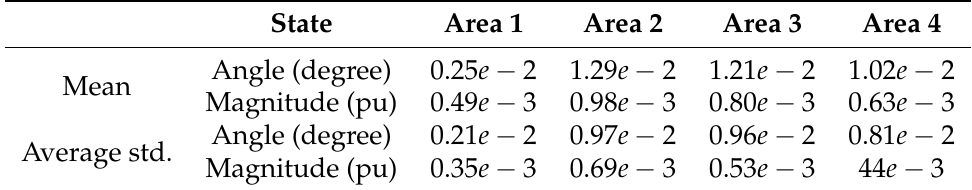
Table 2. Statistic metric per state per area on IEEE -14 (local states only).